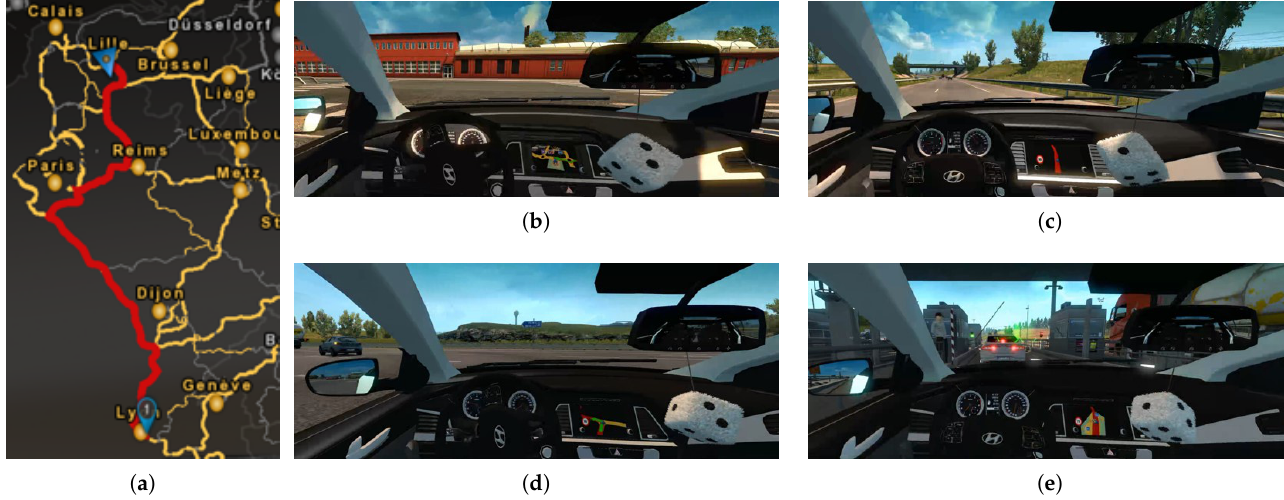
Figure 8. Driving route and road types included in simulation: ( a ) driving route for data acquisition, ( b ) urban road, ( c ) highway, ( d ) crossroad, and ( e ) toll